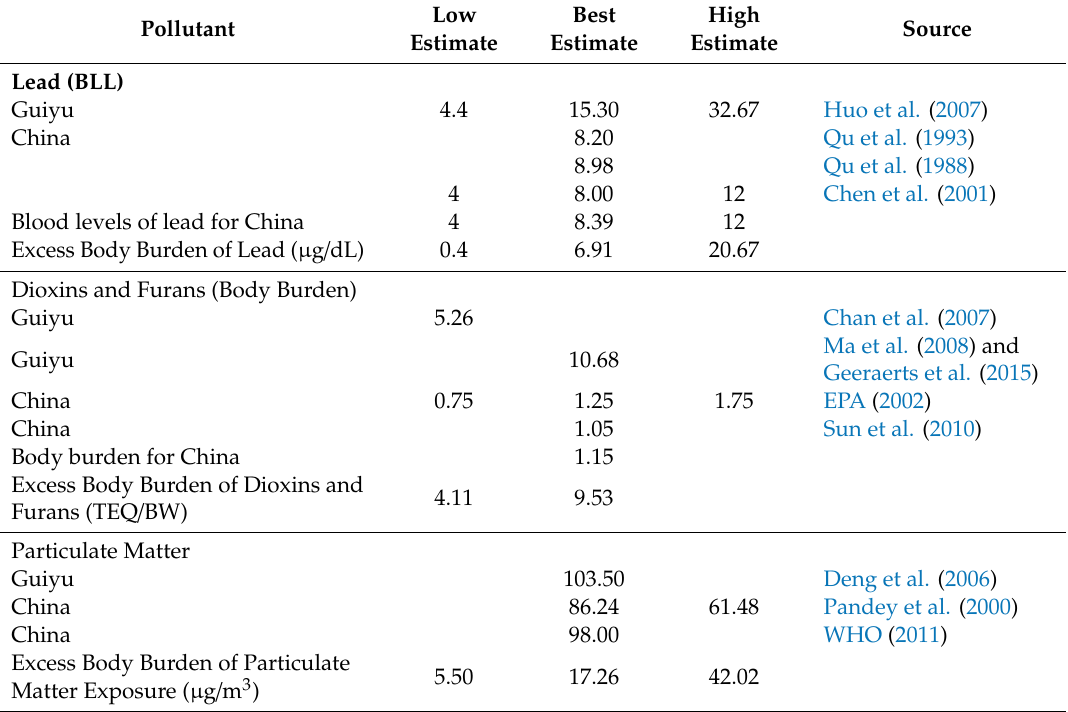
Table 2. Excess Body Burdens in Guiyu: Comparison of Body Burdens in Guiyu with the rest of China. Pollutant